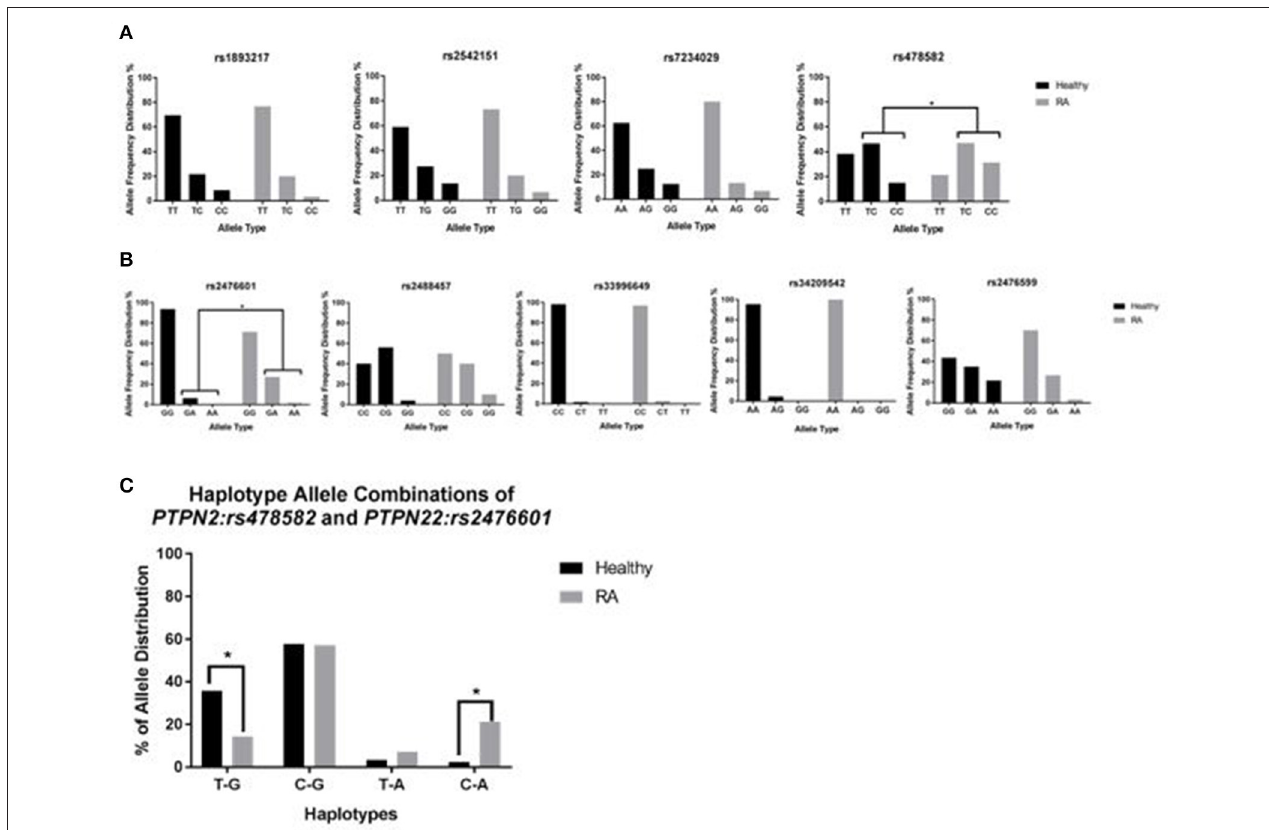
FIGURE 3 | Genotyping of 9 SNPs in PTPN2/22 in RA. (A) Represents the allele frequency in PTPN2: rs1893217 , rs2542151 , rs7234029 , rs478582 . (B) Represents the allele frequency in PTPN22: rs2476601 , rs2488457 , rs33996649 , rs34209542 , rs2476599 . (C) Represents haplotype combinations between PTPN2:rs478582 and PTPN22:rs2476601 including T-G (major/major), C-G (heterozygous or minor/major), T-A (major/heterozygous or minor), and C-A (minor/minor). * P -values ≤ 0.05.